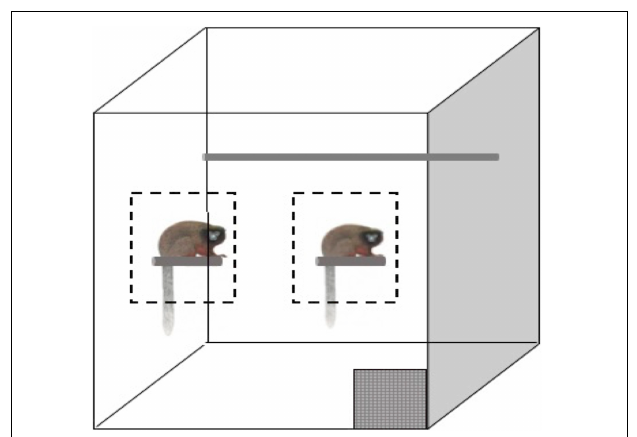
FIGURE 1 | Simplified representation of the titi monkey home cage. The gray checkered box is the release door, the gray cylinder each animal is sitting on represents a perch and trained/testing zones are indicated by dashed outlines. Not to